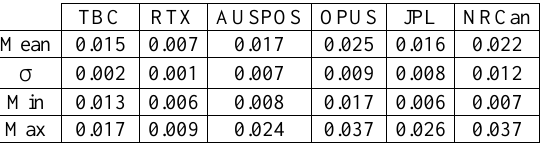
Table 1. Statistics for the 3D coordinate difference (all